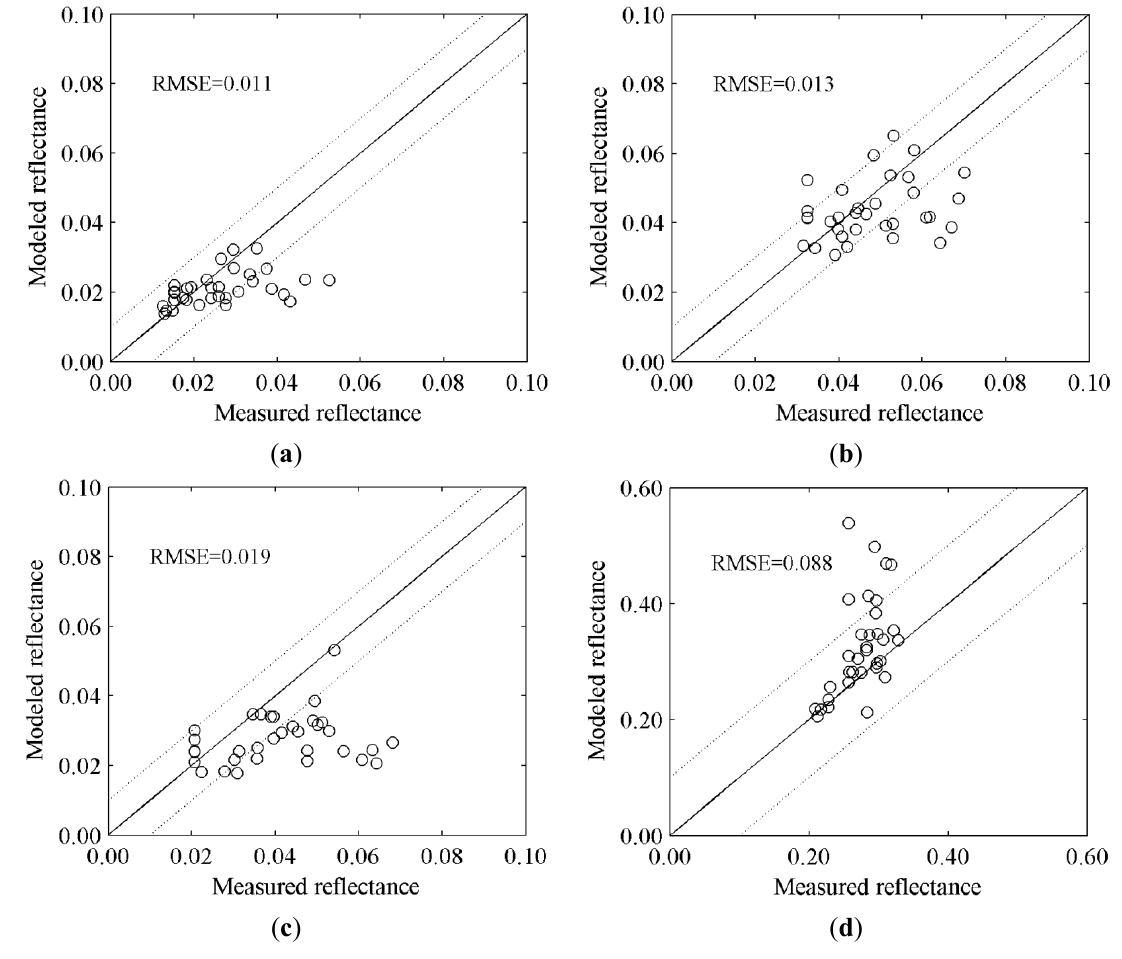
Figure 10. Modeled and measured forest canopy reflectance (33 plots from ‘normal’ terrain—high cos i ) in different wavebands: ( a ) blue band; ( b ) green band; ( c ) red band and ( d ) near-infrared band of Landsat-8. The 1:1 line is shown as continuous line. The dotted lines in (a), (b) and (c), are described as y = x ± 0.01, and in (d), y = x ± 0.1. Table 5. Accuracy of INFORM reflectance simulations with field measured canopy characteristics as inputs. The RMSE is between INFORM simulations and Landsat-8 observations. We distinguish steep terrain (e.g., low cos i ) and normal terrain (e.g., high cos i ). “Steep” Terrain (LOw cos i